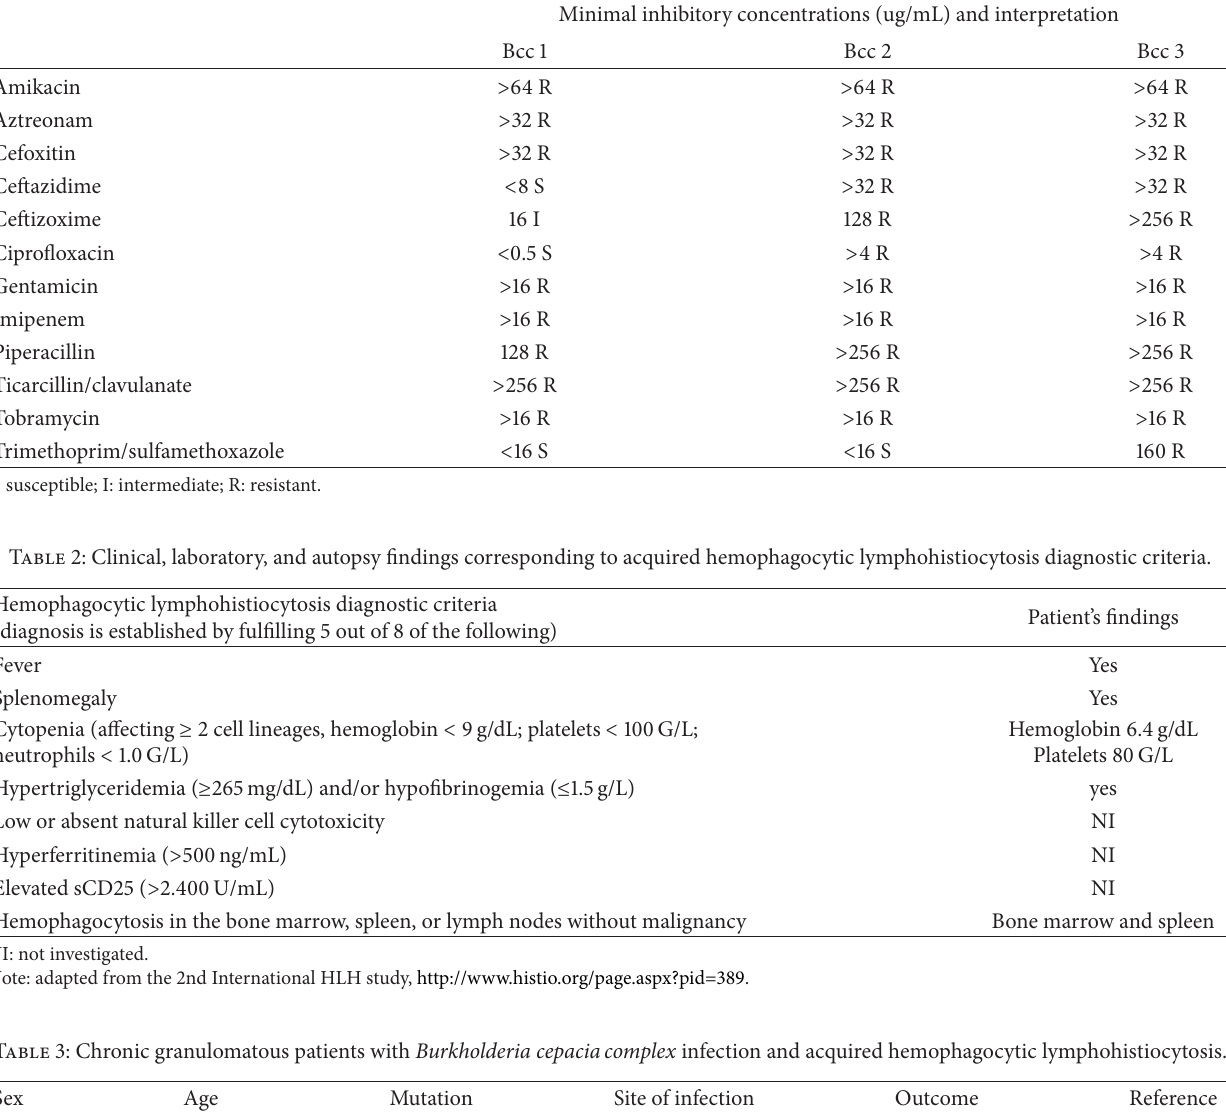
Table 1: In vitro sensitivity of the 3 types of Burkholderia cepaciacomplex (Bcc) isolated from sputum cultures. Minimal inhibitory concentrations (ug/mL) and interpretation